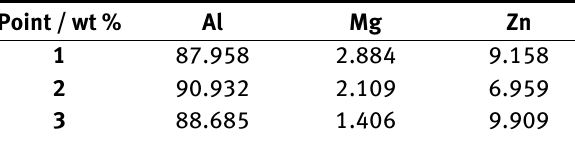
Table 2: EDS results of the AA7075 alloy applied solid solution at 485 ∘